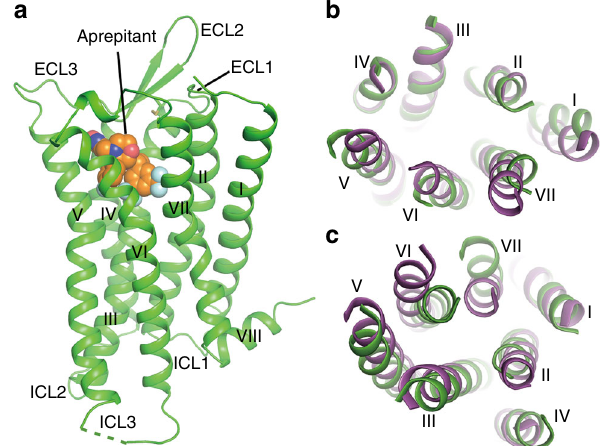
Fig. 1 Overall structure of the NK1R – aprepitant complex. a Structure of the NK1R – aprepitant complex. The NK1R structure is shown as green cartoon. Aprepitant is shown as spheres with orange carbons. The disul fi de bond is displayed as yellow sticks. The missing portion of ICL3 is indicated by a green dashed line. b , c Structural comparison between NK1R and NTSR1 (PDB accession code: 4GRV). The helical bundles of the receptors are colored green (NK1R) and purple (NTSR1). b Extracellular view.